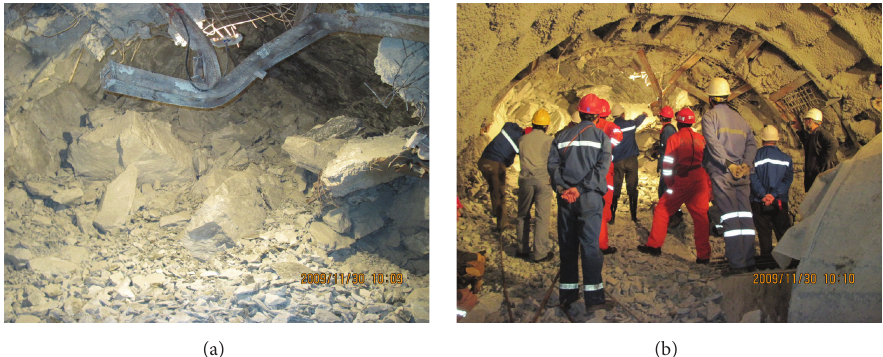
Figure 1: On-site photos showing strong rockburst failure in drainage tunnel at Jinping II Hydropower Station, Sichuan, China (November 28, 2009). (a) The support systems were seriously damaged and a large area of rocks burst and collapsed. (b) Experts investigated the accident scene after the strong